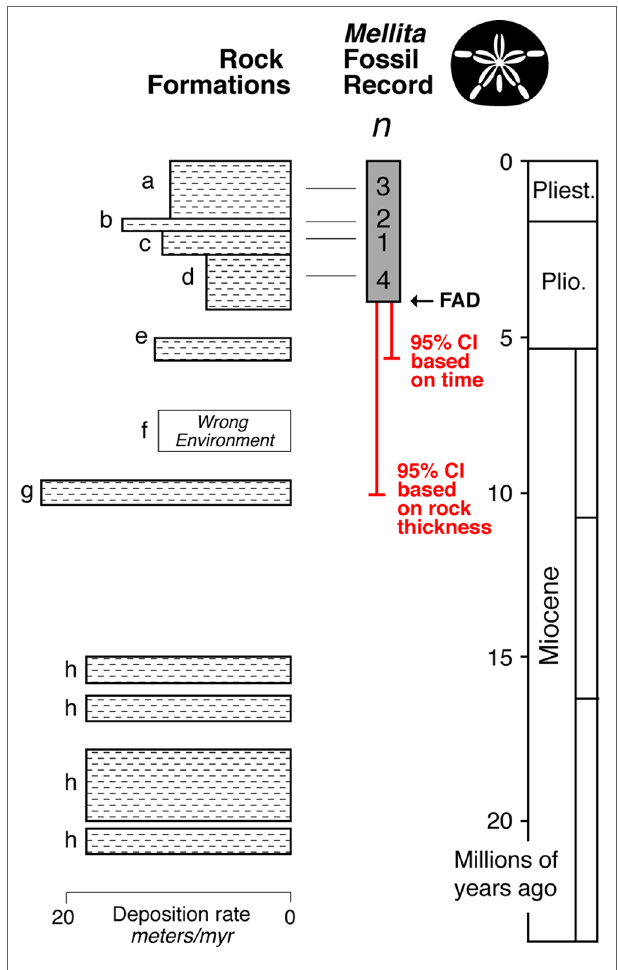
FIGURE 6 | Idealized representation of the rock formations on the Atlantic Coastal Plain region of the USA (Lindberg, 1983), with the fossil record and minimum number of localities ( n ) for each formation for the fossil sand dollar Mellita (silhouette). The FAD in this region is ~4 million years old, with the end of the 95% confidence interval (equation 1) extending to ~5 million years ago. However, when one takes into account the substantial gaps in the rock record, and the fact that some rock formations were deposited in environments inimical to Mellita (formation f), the 95% confidence interval extends to ~10 million